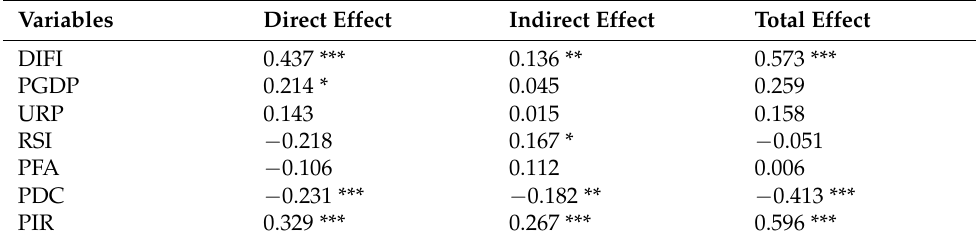
Table 9. Direct and indirect effects of DIF on